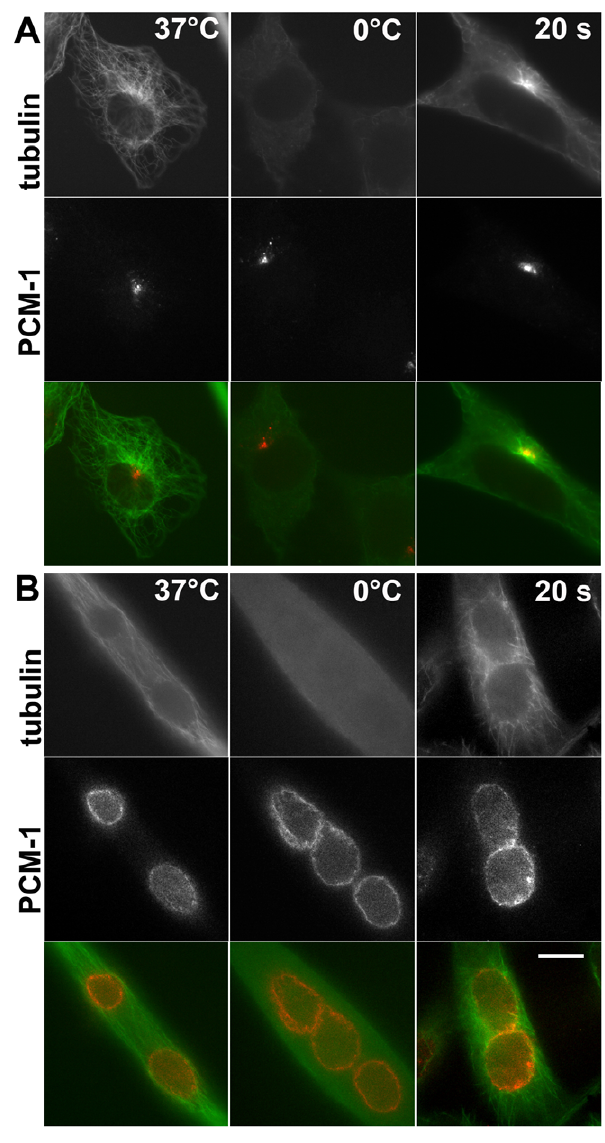
Figure 1. In myotubes, microtubules are nucleated from the nuclear surface. (A) Immunofluorescence of undifferentiated H-2K b - tsA58 mouse myoblasts, and (B) differentiated, fused H-2K b -tsA58 myotubes, stained for tubulin (green), and for the centrosome protein PCM-1 (red). Left: cells at 37 u C, displaying an intact microtubule network. Middle: depolymerization of microtubules after treatment on ice for three hours. Right: microtubule re-growth, 20 seconds after shifting cells to 37 u C. A small centrosomal microtubule aster is seen in the undifferentiated cell (A), whereas sun-like rays of microtubules emanating from the nuclear surface are seen in myotubes (B). Bar in B, 10 m m. Identical magnifications in A and B. doi:10.1371/journal.pone.0008303.g001 the cells to 37 u C for several seconds, new microtubule asters were nucleated by the centrosome (Fig. 1A). In comparison, differen- tiated H-2K b -tsA58 cells that had fused into myotubes showed longitudinally oriented microtubules prior to depolymerization. Likewise, these microtubules disappeared after cold treatment. After re-warming, the highest density of re-growing microtubules was seen around the surface of each nucleus (Fig. 1B), consistent with a previous report [6]. The pattern of re-growing microtubules was reminiscent of sun-like arrays (Fig. 1B).